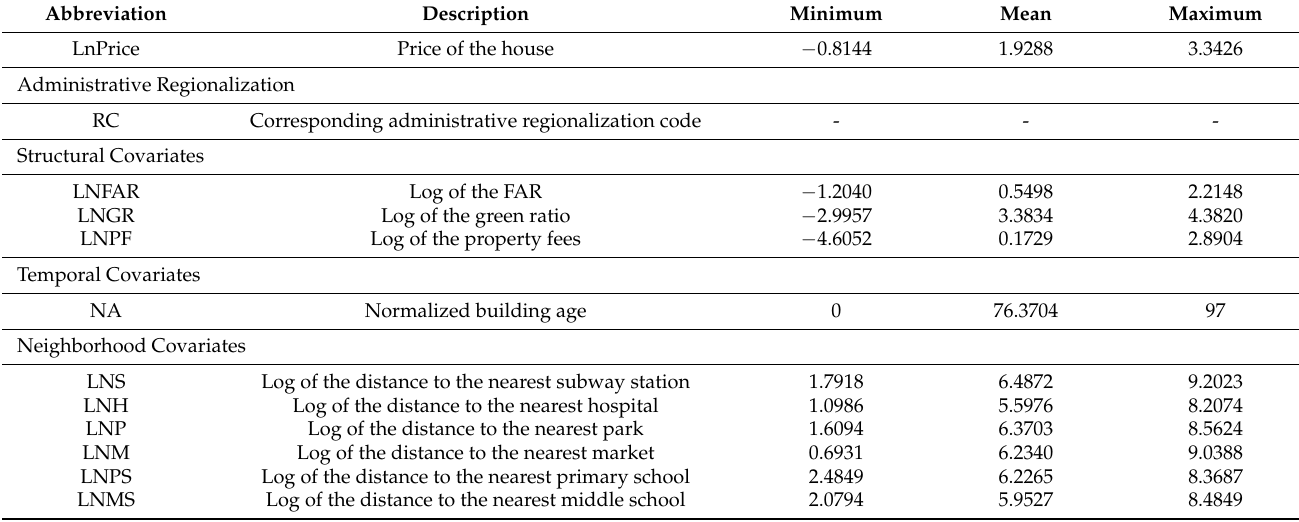
Table 1. Variables used to predict housing prices in Beijing,